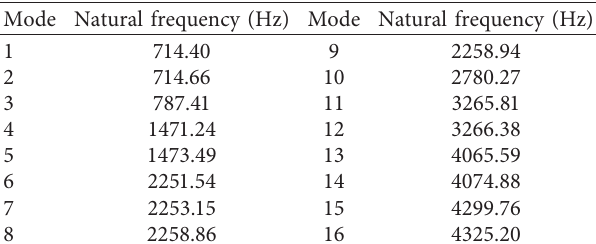
Figure 12: Test model of the